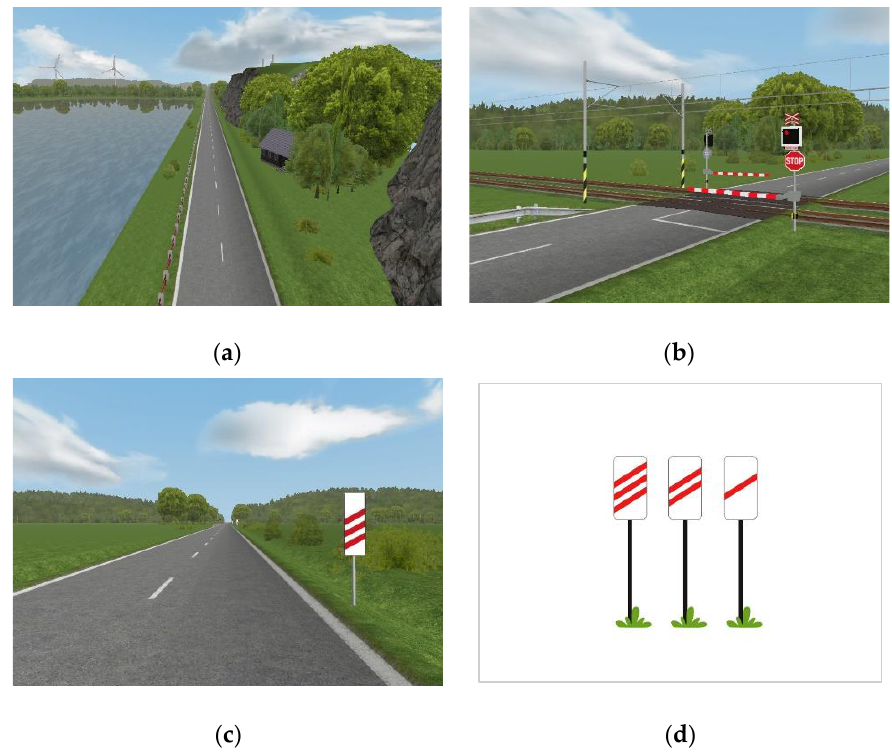
Figure 4. The driving scenario used for our experiment: ( a ) illustrates the track road; ( b ) illustrates the stop line representing the target point; ( c ) illustrates the warning signs used as a deceleration signal in the scenario with warning signs and ( d ) illustrates the three “Countdown Markers” placed at distances to the Stop line.